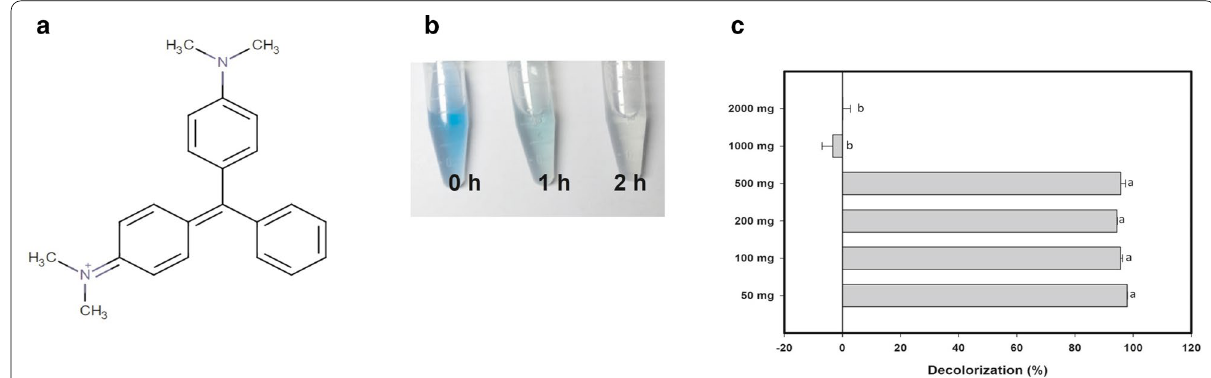
Fig. 7 Effect of LacMeta on degradation of Malachite Green. a Chemical structure of the dye Malachite Green. b Illustration of the decoloration of malachite green when subjected to enzymatic treatment with 0.1 mM ABTS as a redox mediator and stirring (150 rpm) for 2 h. c Effect of concentration on Malachite Green percentage of discoloration